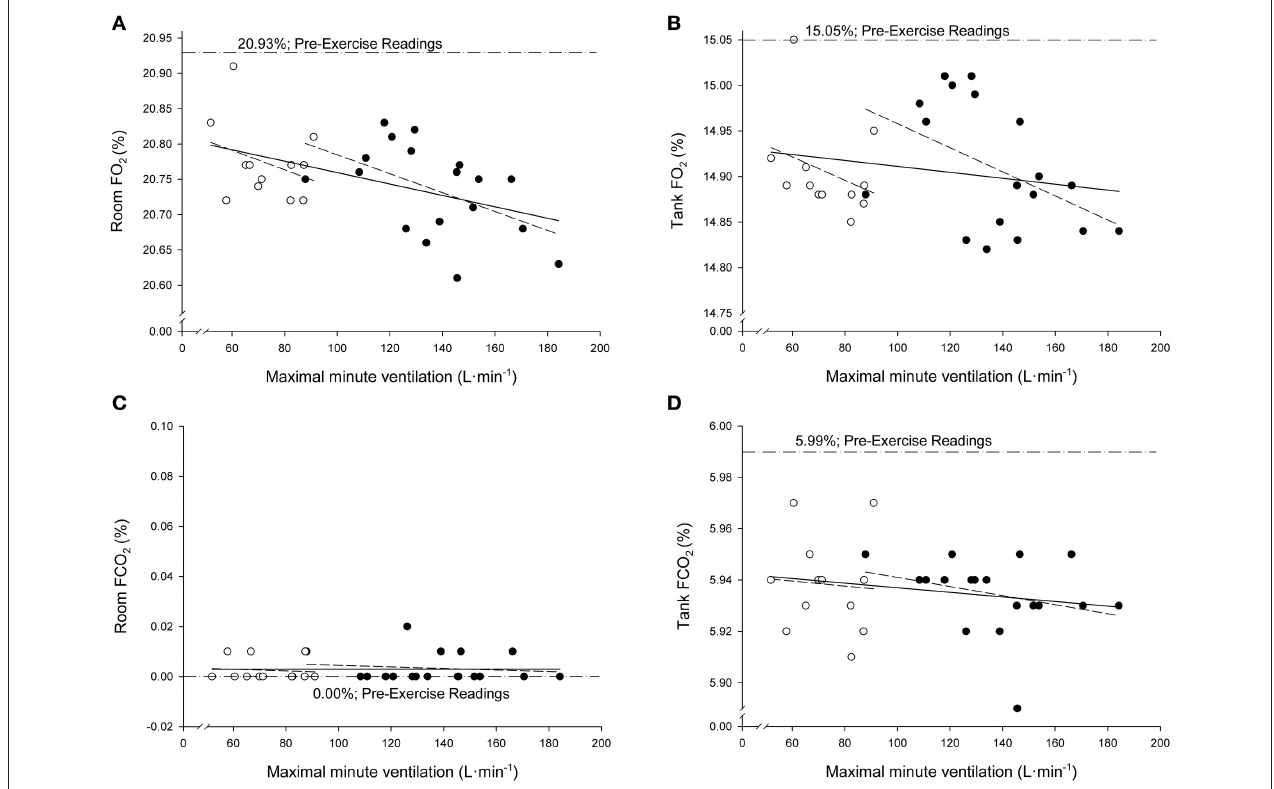
FIGURE 2 | Relationships between the individual values of maximal minute ventilation and the individual post-test verification values of fractional concentrations of oxygen (FO 2 ; A,B) and carbon dioxide (FCO 2 ; C,D) when both calibration gases (room air and tank gas) were run through the metabolic system after maximal exercise. Open circles: elderly sedentary subjects. Filled circles: young